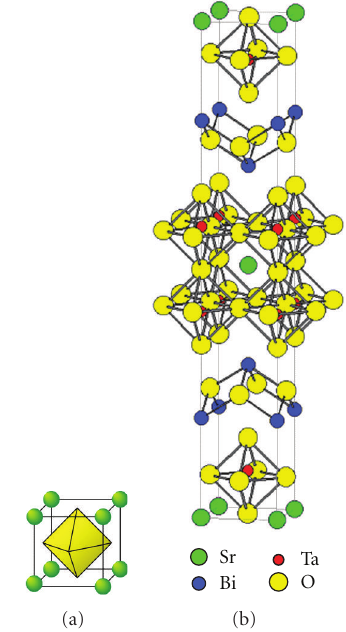
Figure 7: Crystal structure of (a) fundamental perovskite and (b) Bi-layered perovskite SrBi 2 Ta 2 O 9 (upper half of the unit cell) [11,